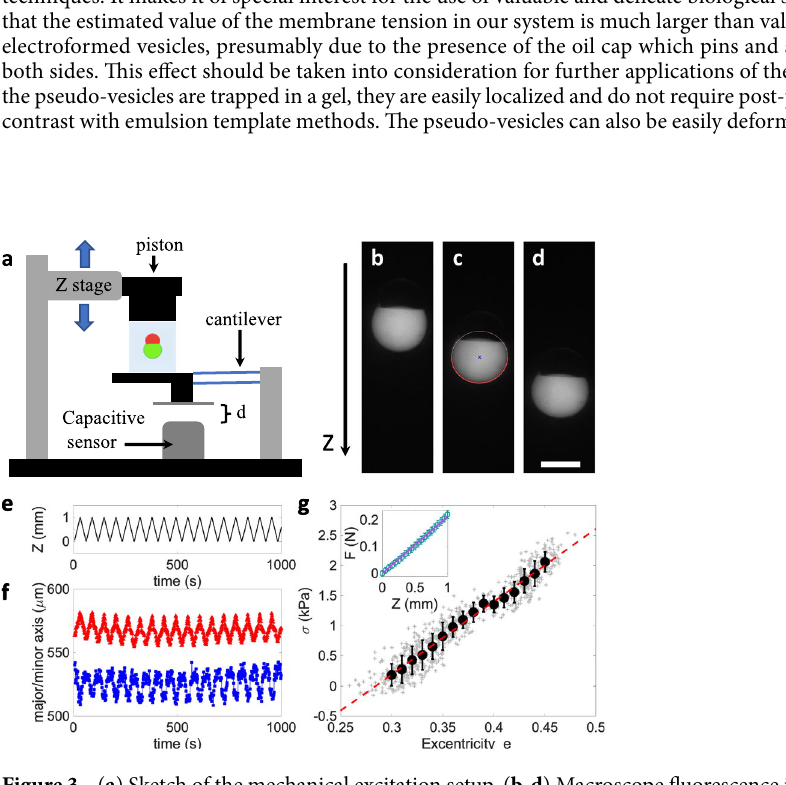
Figure 3. ( a ) Sketch of the mechanical excitation setup. ( b - d ) Macroscope fluorescence images of pseudo- vesicles either relaxed (( b ) Z =0) or deformed ( Z =0.5 and 1 mm in ( c , d ), respectively). In ( c ) the red line is the fit of the contour of the lower part of the pseudo-vesicle with an ellipse. Scale bar = 400 µ m. ( e ) Piston position Z ( t ). ( f ) Major (red) and minor (blue) axes of the fitted ellipse as a function of time, for a 1000 s long cyclic indentation. ( g ) Compressive stress σ as a function of the ellipse’s eccentricity e . Grey crosses correspond to all data points from ( f ), black circles are averages within bins of eccentricity δ e = 0.01. Error bars are SD of the data. The red doted line is a linear fit to the data. Inset: Normal force as a function of the piston indentation. The line is a linear fit F = κ z , from which the gel compression modulus can be deduced, K gel = κ H / S , with H the height of the